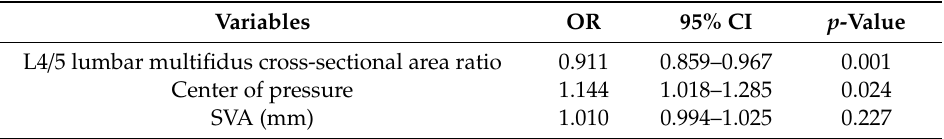
Table 3. Factors associated with fall risk in the stepwise logistic regression analysis (fall risk group, n = 30; non-fall risk group, n = 69).